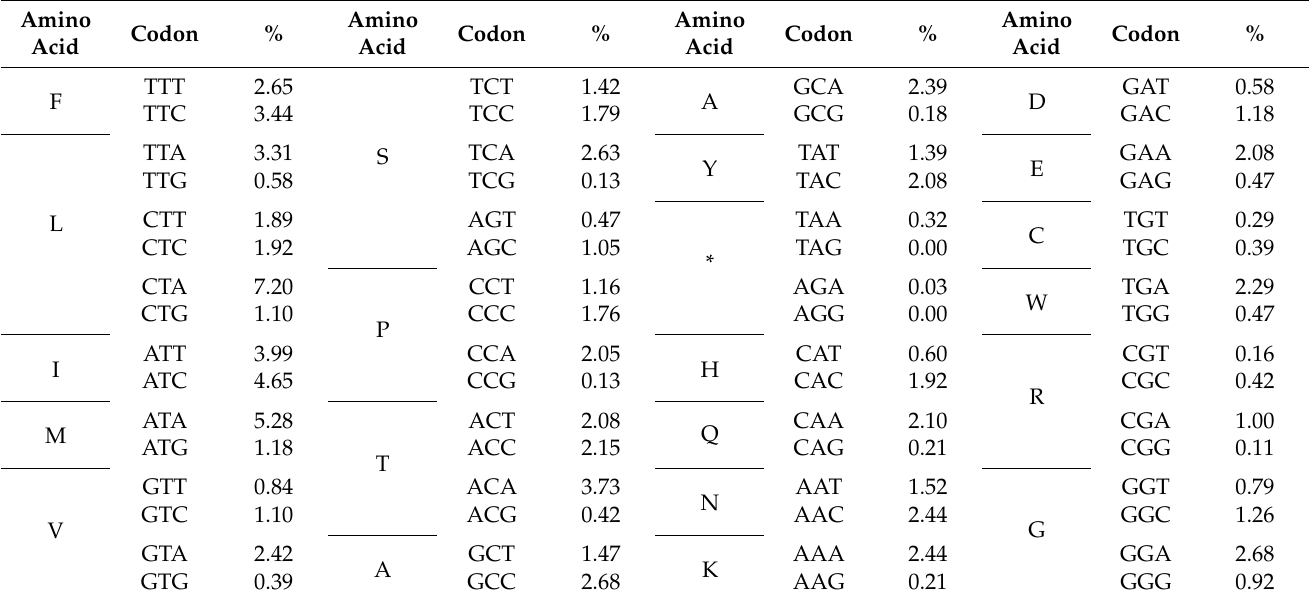
Table 2. Codon usage table of 13 mitochondrial protein-coding genes of European mink (including presumed polyadenylated incomplete termination codons [31]).